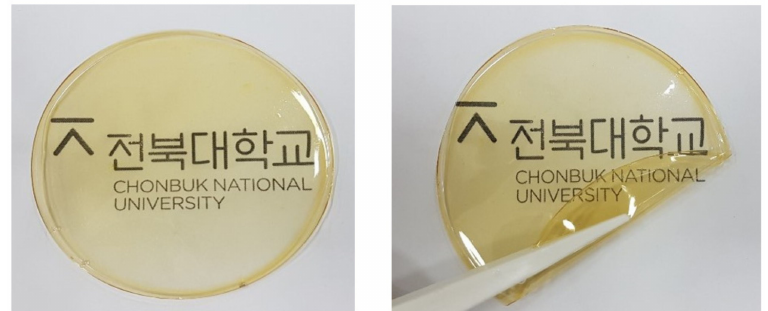
Figure 1. Photographs of